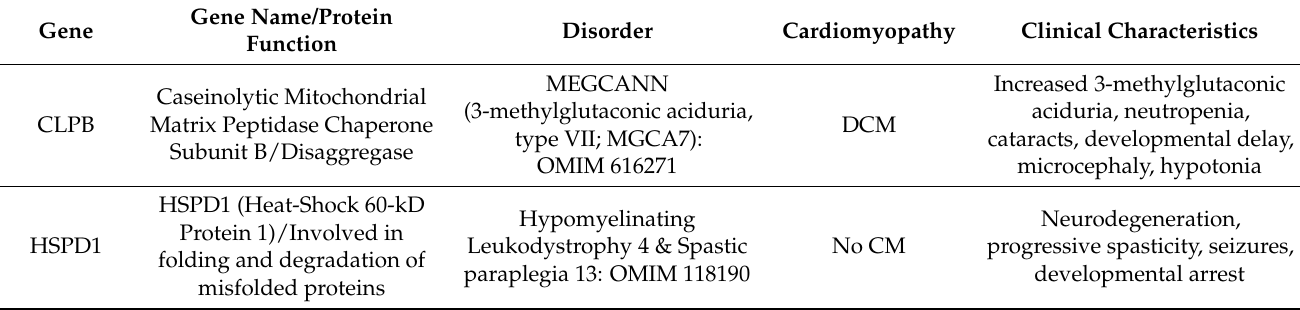
Table 3. Disorders presenting with cardiomyopathy resulting from mutations in genes encoding chaperones. Formal Online Mendelian Inheritance in Man (OMIM) report, protein function, and clinical characteristics are